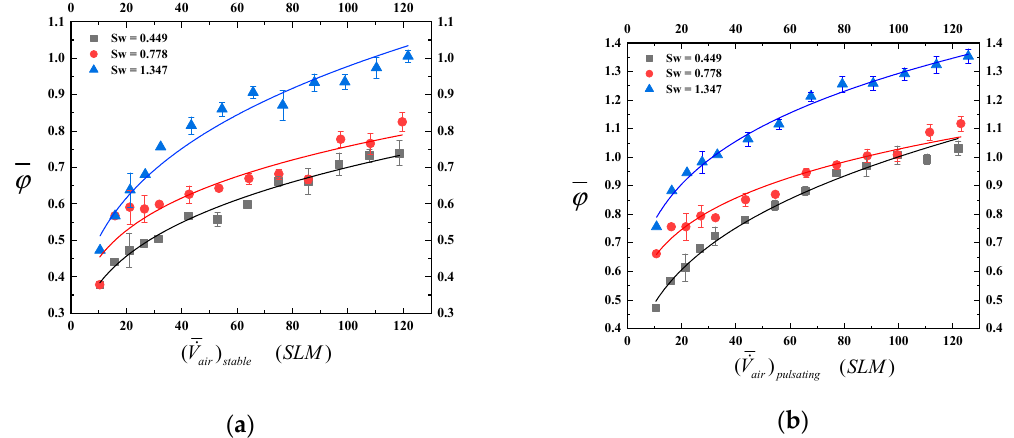
Figure 10. ( a ) The lean blowout limits in stable flow mode; ( b ) The lean blowout limits in pulsating flow mode.